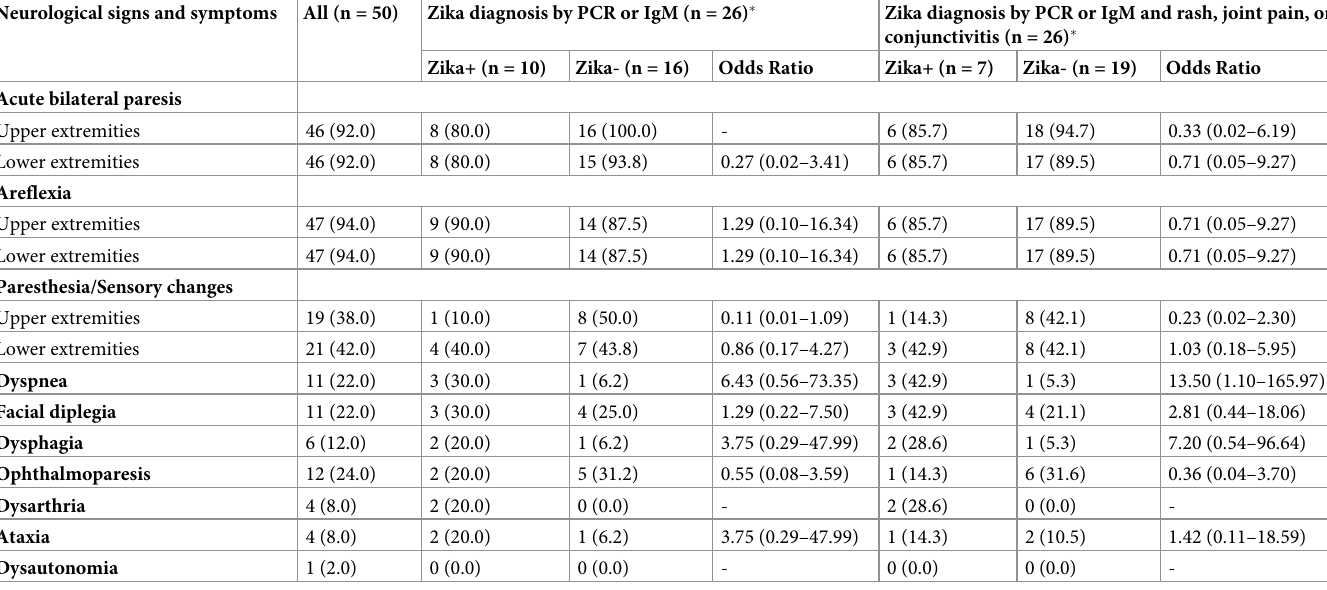
In total, 48% had complete neurophysiological studies for analysis. These revealed a pre- dominance of AMAN compared to demyelinating subtype (Table 7). Treatment was initiated with intravenous immunoglobulin in 68% and plasmapheresis in 20% (Table 7). Mechanical ventilation was required in 12% of patients, and significantly more ZIKV-positive case-patients (diagnosed by PCR and at least one antecedent typical ZIKV symptom) required mechanical ventilation than ZIKV negative case-patients (OR: 13.67, 95% CI: 1.88–99.35). There was one in-hospital death after a long stay in the intensive care unit.